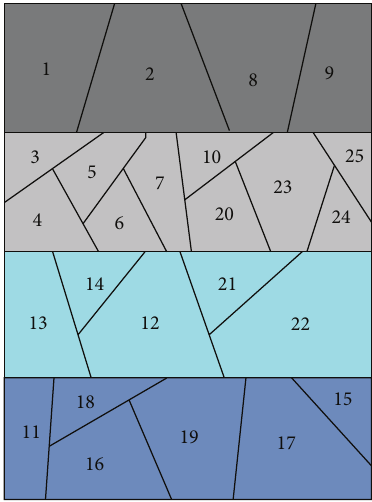
Figure 2: A schematic diagram of dividing airspace into 4 regions.